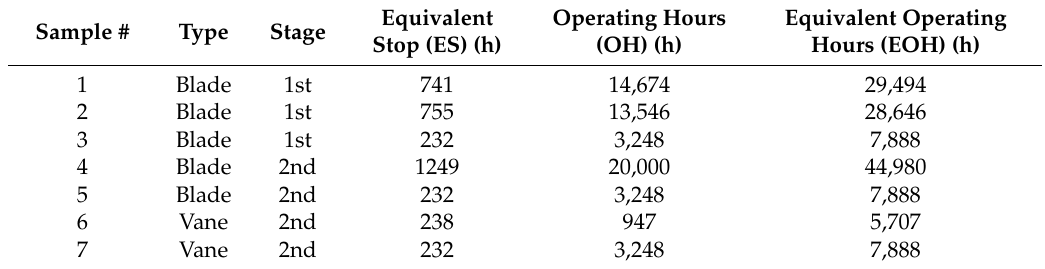
Table 1. The operational history of the blades and vanes scrapped from power plant